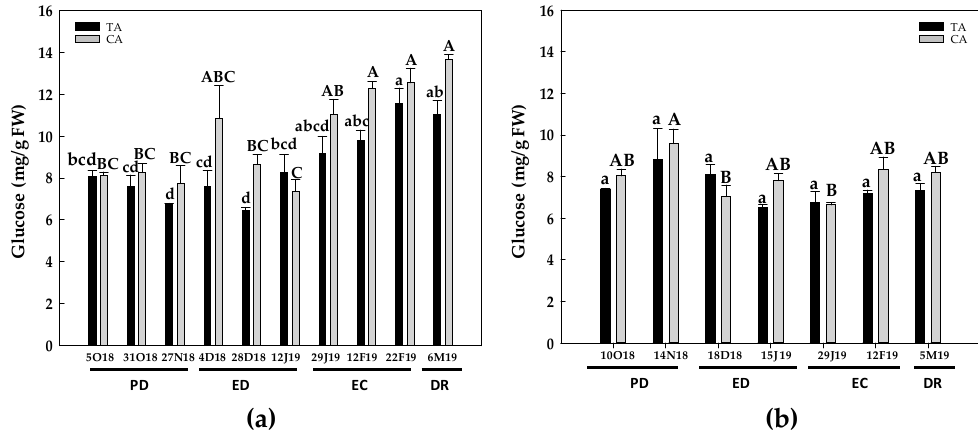
Figure 4. Evolution of glucose contents in flower buds of peach ‘GEM020’ cultivated in two different geographical areas during the dormancy cycle on two seasons. ( a ): season 1 (2017–2018); ( b ): season 2 (2018–2019). Data represent the mean ± SE, n = 5. Different letters (lowercase and uppercase for the samples of the temperate (TA) and the cold area (CA), respectively) indicate significant differences according to Tukey’s multiple test ( p ≤ 0.05). PD: paradormancy; ED: endodormancy; EC: ecodormancy; DR: dormancy release. FW: fresh weight. The chill units accumulated at the different times and locations are shown in Supplemental file 1.